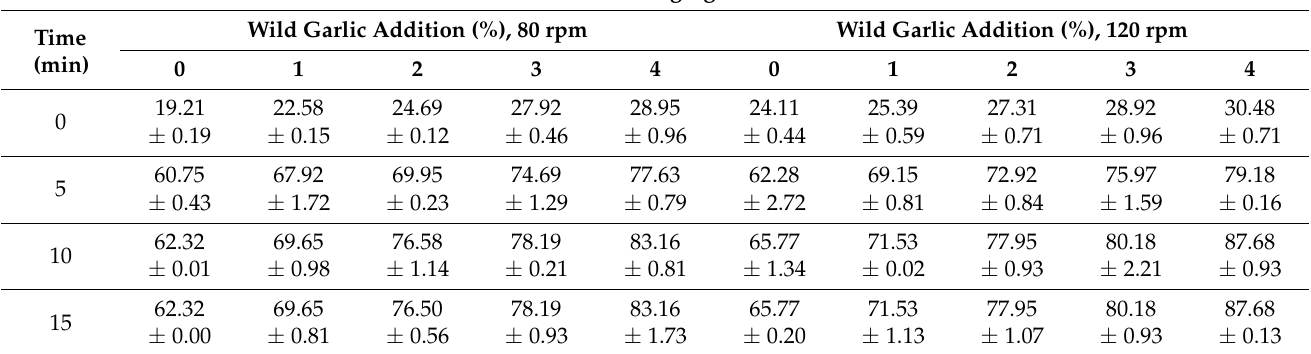
Table 3. DPPH radical scavenging activity of corn snacks enriched with wild garlic extruded at two different screw speeds (n = 3; mean ±